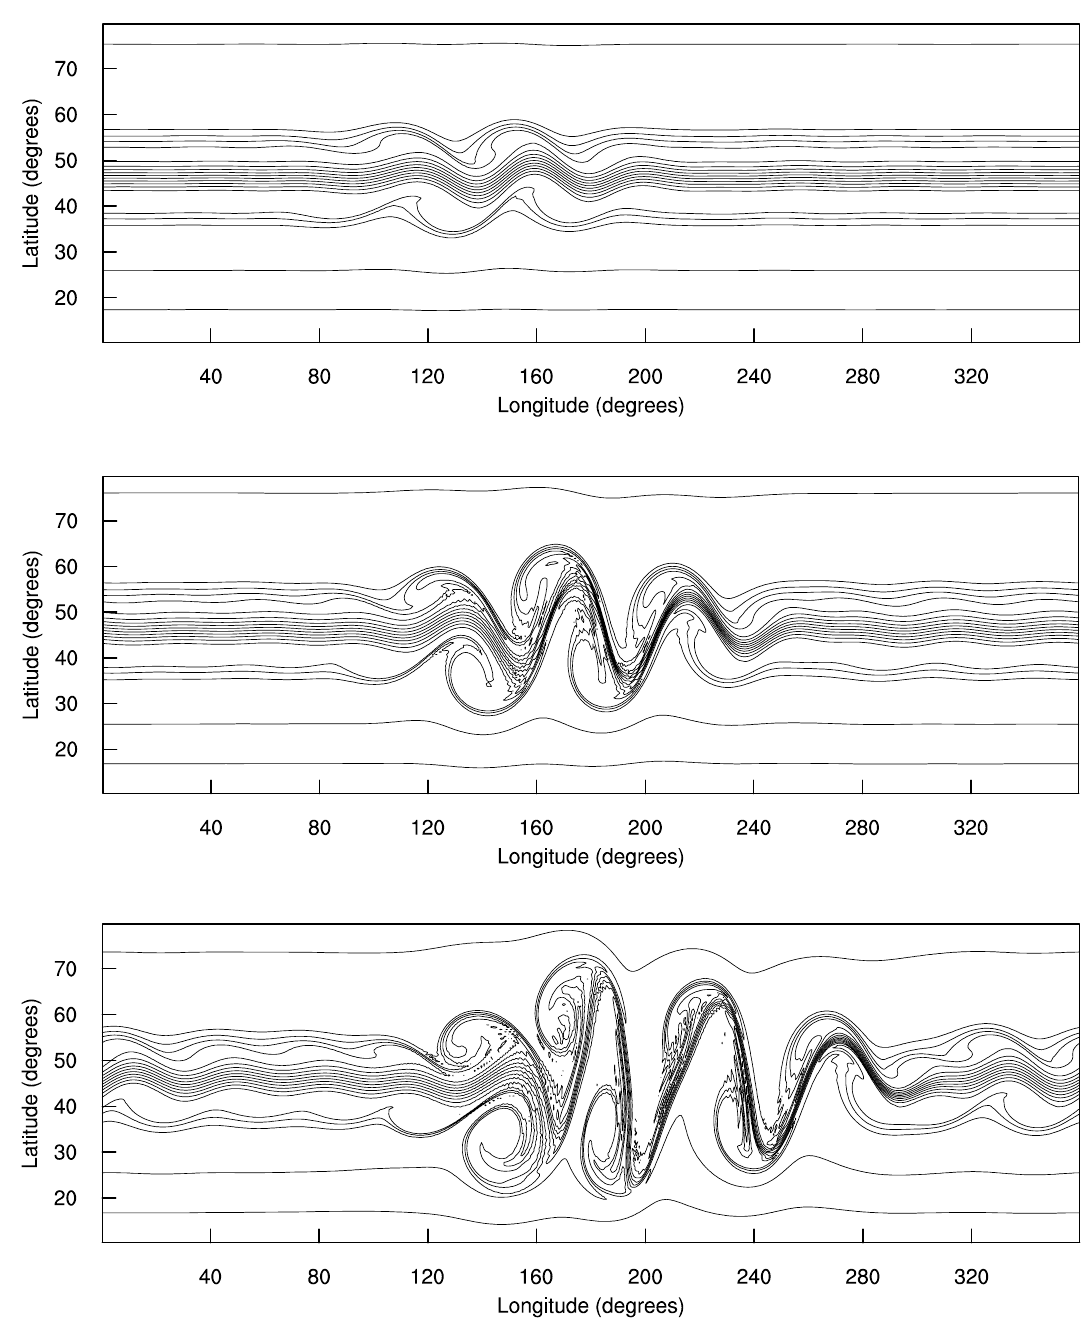
Figure 8. Absolute vorticity forecasts at 96 h ( top ), 120 h ( middle ), and 144 h ( bottom ).